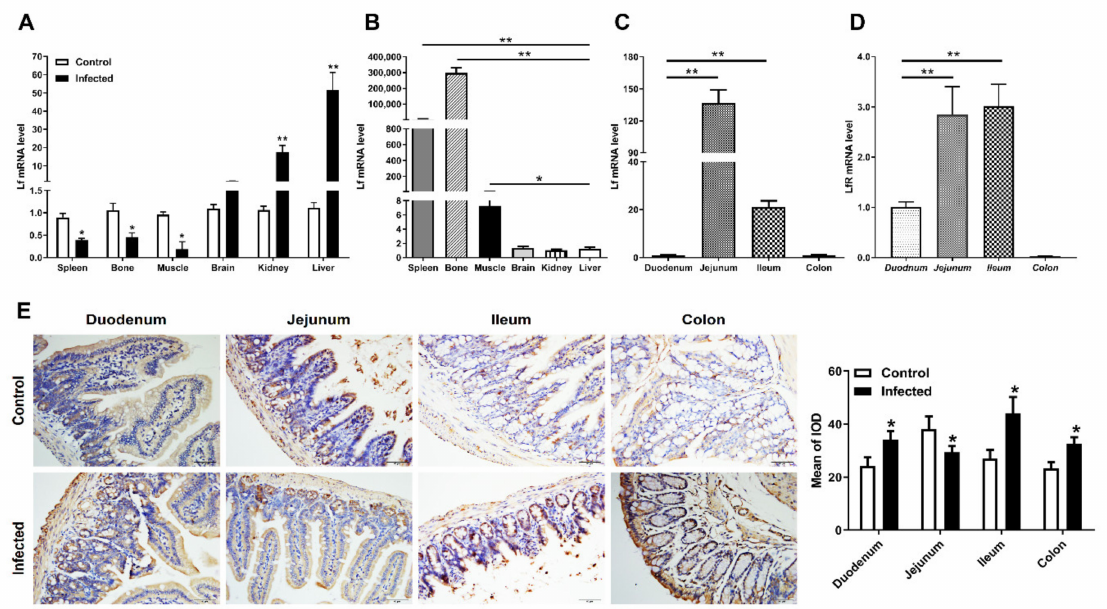
Figure 3. Distribution of Lactoferrin (Lf) and neutrophils in the intestine. ( A ) The changes of mRNA expression of Lf in other organs of challenged mice. ( B – D ) The mRNA expression of Lf in tissues and the intestine of wild type mice. ( E ) Representative images of the infiltration of neutrophils in the duodenum, jejunum, ileum and colon at 0 and 24 h post infection. Original magnification 400 × . Formalin-fixed, para ffi n-embedded 5-mm cross-sections were stained with a primary Ab to myeloperoxidase (MPO). Data are presented as the mean ± SD, n = 6. The values were normalized against the level of GAPDH gene. * Indicates a significant di ff erence ( p < 0.05) and ** Indicates an extremely significant di ff erence ( p < 0.01) compared to that of control group or 0 h post